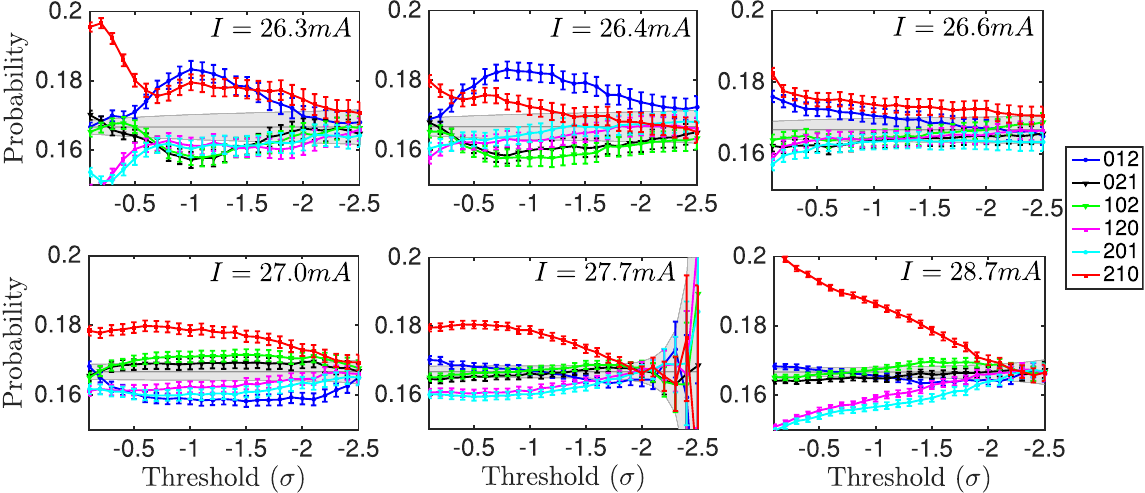
Figure 2. Words probabilities of dimension 3 versus threshold, computed with the time intervals between events, for different pump currents. Only events deeper than the threshold are considered. The error bars represent the confidence interval computed with a binomial test, corresponding to a confidence level of